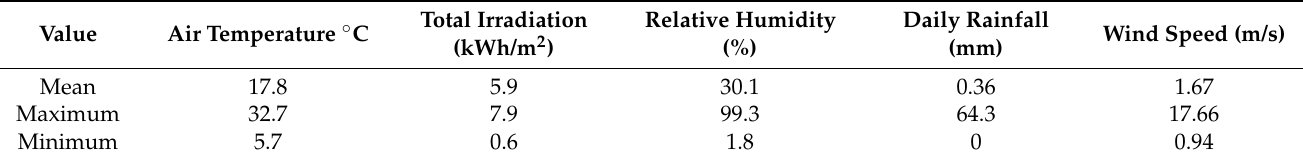
Table 5. Mean, minimum, and maximum values of weather conditions during exposure period time at the desert site.